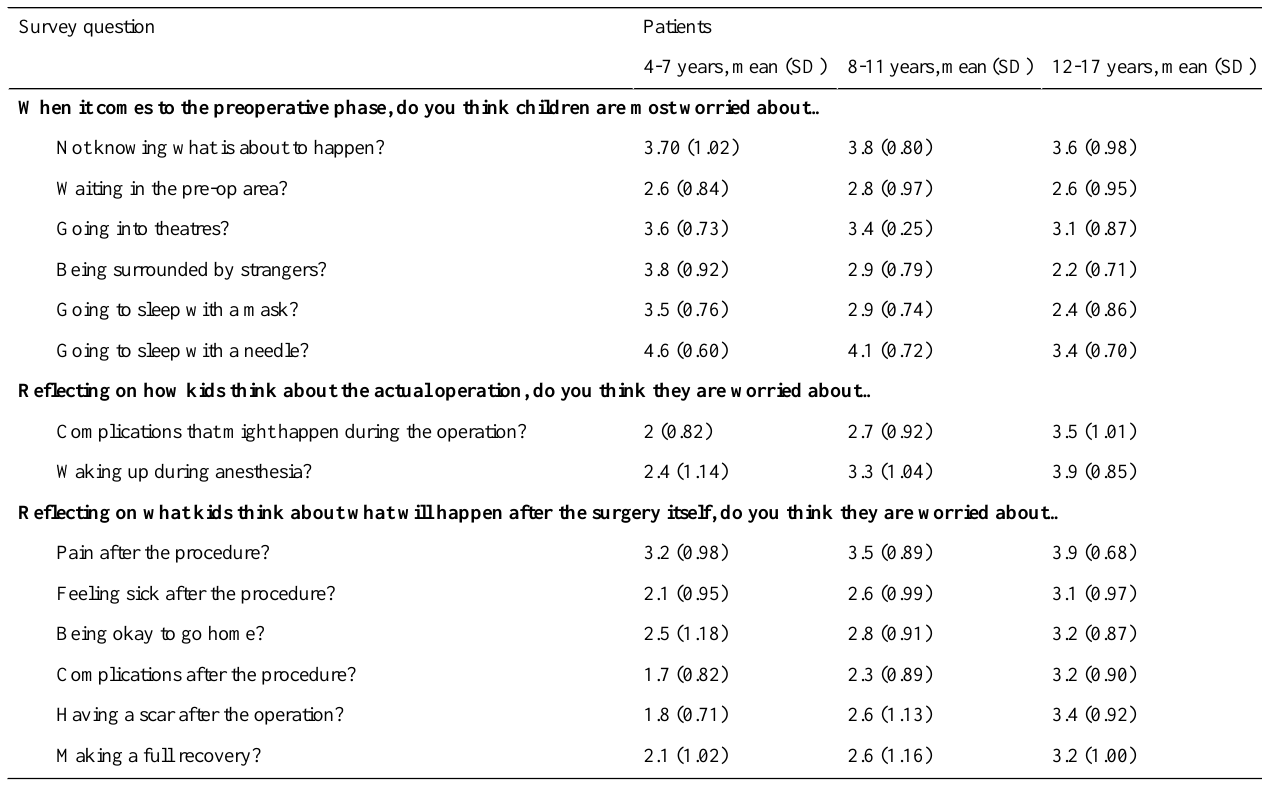
Table 1. The average rating (likelihood of each item occurring on a 5-point scale ranging from “not at all” to “very much”) of clinician’s responses to the repeated survey on the experience of pediatric patients in three age groups